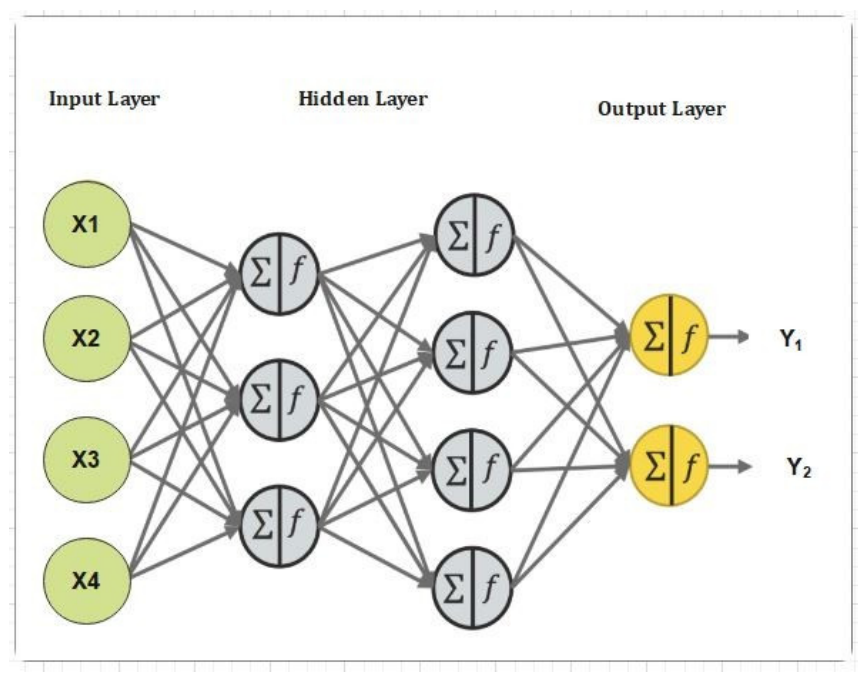
Figure 5. The proposed Neural Network system for fog-computing.